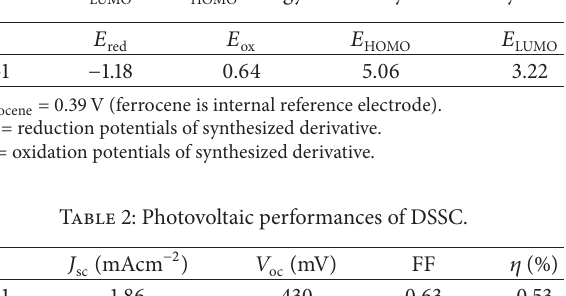
and 𝐸 energy levels of synthesized dye. LUMO HOMO 𝐸 𝐸 red ox